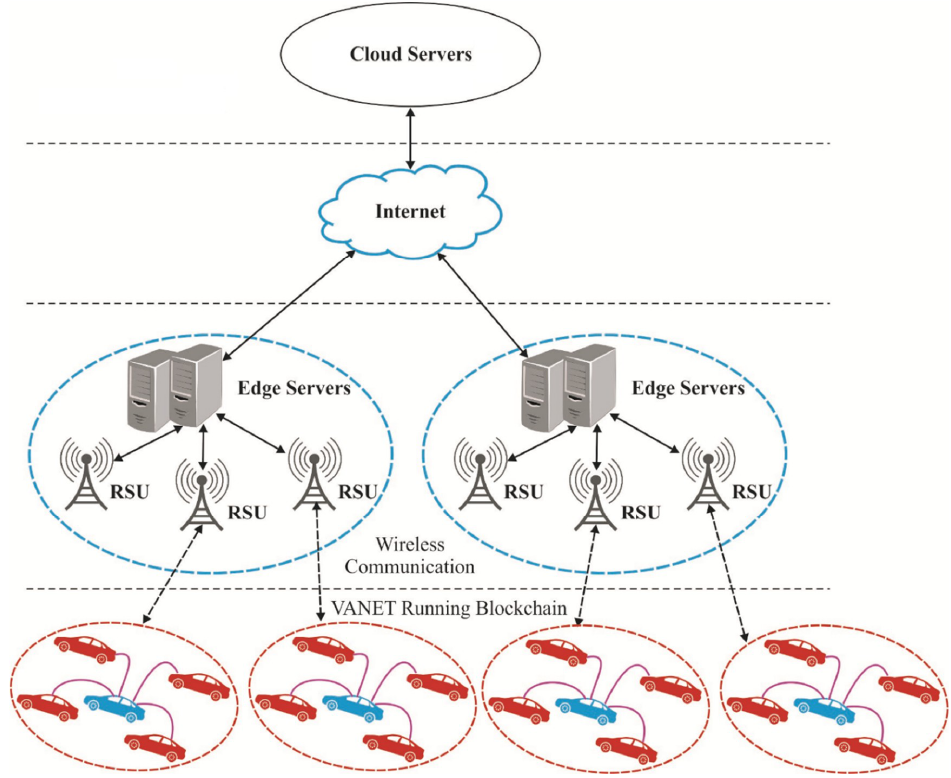
Figure 2. Architecture of the ROA-based clustering with blockchain-based data transmission (ROAC-B) technique.